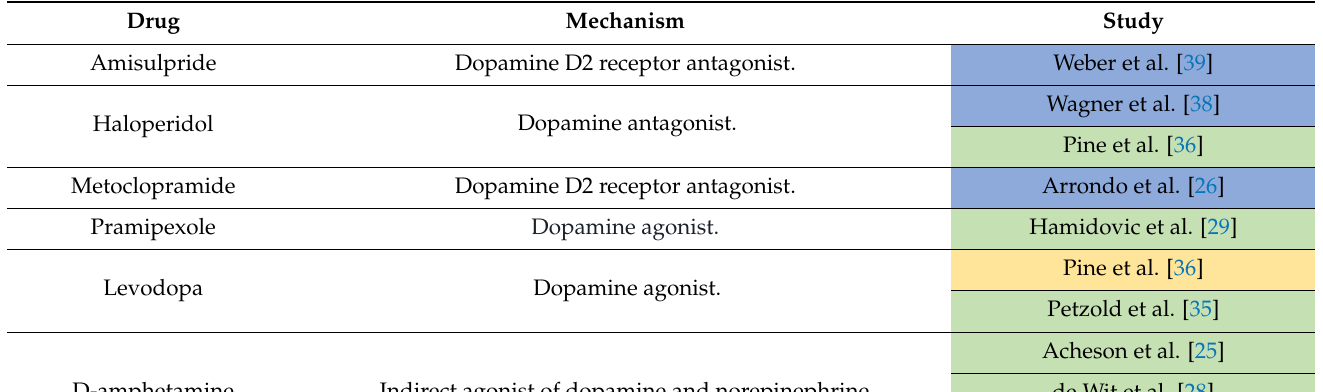
Table 3. Drug’s mechanism of